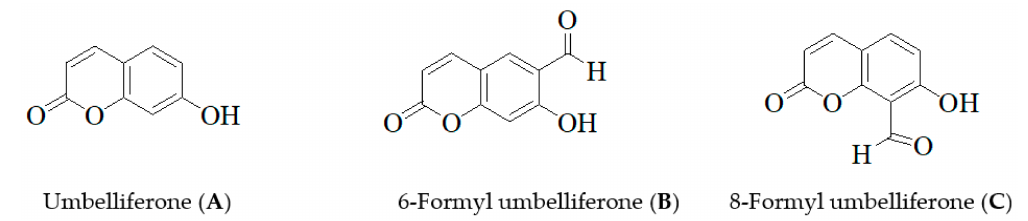
Figure 1. Chemical structures of unsubstituted ( A ), 6-formyl ( B ) and 8-formyl ( C )